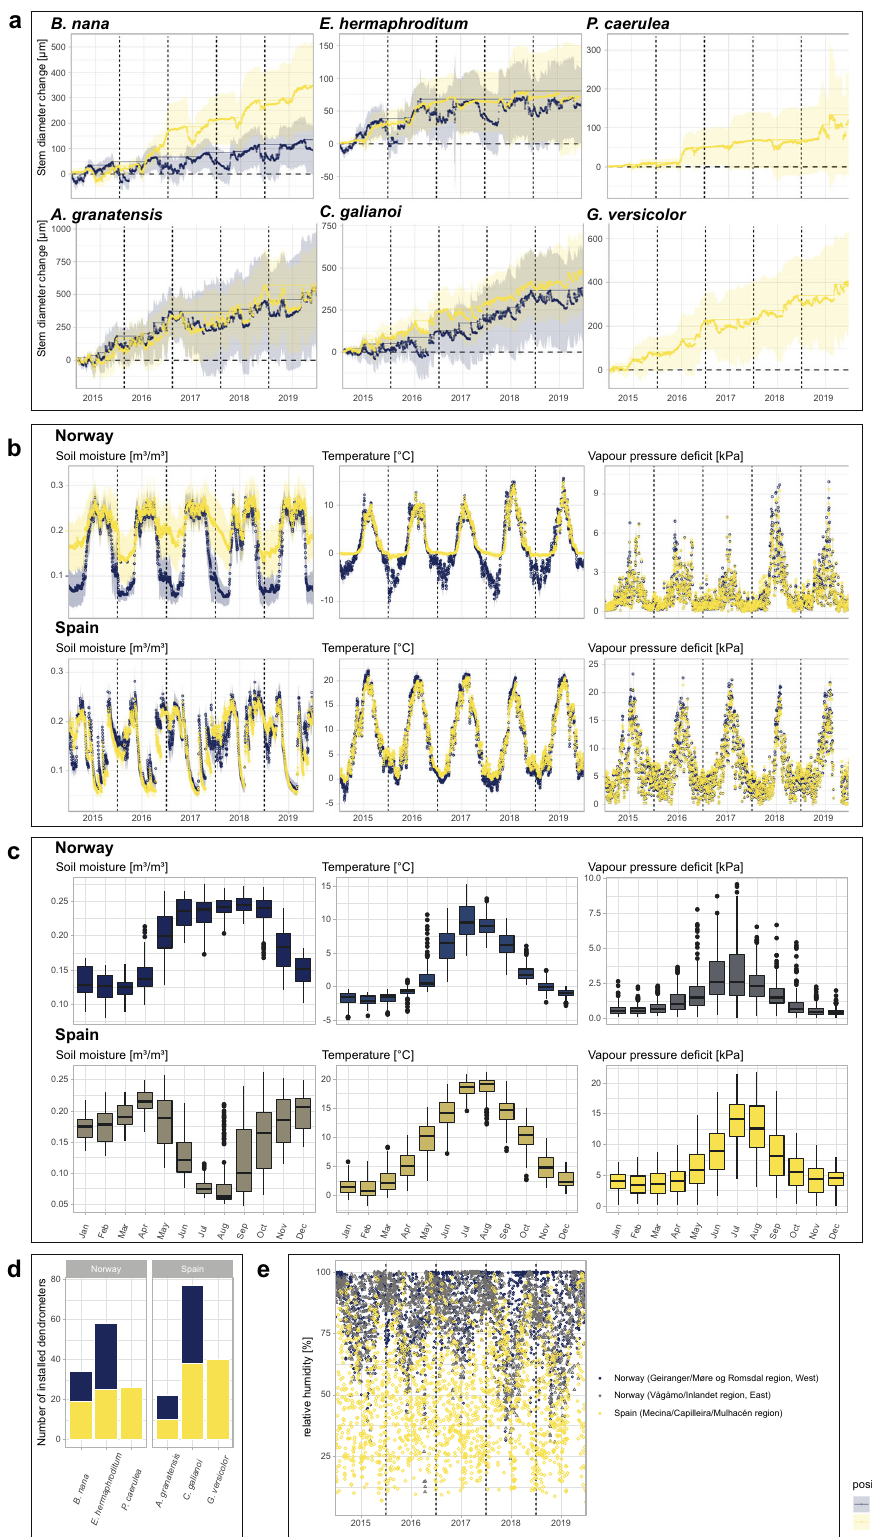
Fig. 2 Summary of dendrometer measurements and environmental data. Averaged stem diameter change 2015 – 2019 ( a ) at topographical ridge (blue) and slope (yellow) positions. For B. nana , there was some stem increment measured during the winter of 2016 for individual specimens at the slopes, related to snow weight causing technical dif fi culties. Lines show cumulative stem diameter change and reversible, water de fi cit-induced shrinking derived from these cumulative curves. b , c Summarize daily averaged environmental data (soil moisture, soil temperature, and vapour pressure de fi cit) 2015 – 2019 ( b ) and intra-annual (monthly) variation during the same time period ( c ). The number of dendrometers installed for each species at each topographical position is presented in d , e shows relative humidity values measured at three measurement points. These values, alongside site-speci fi c temperature measurements, were used for calculating vapour pressure de fi